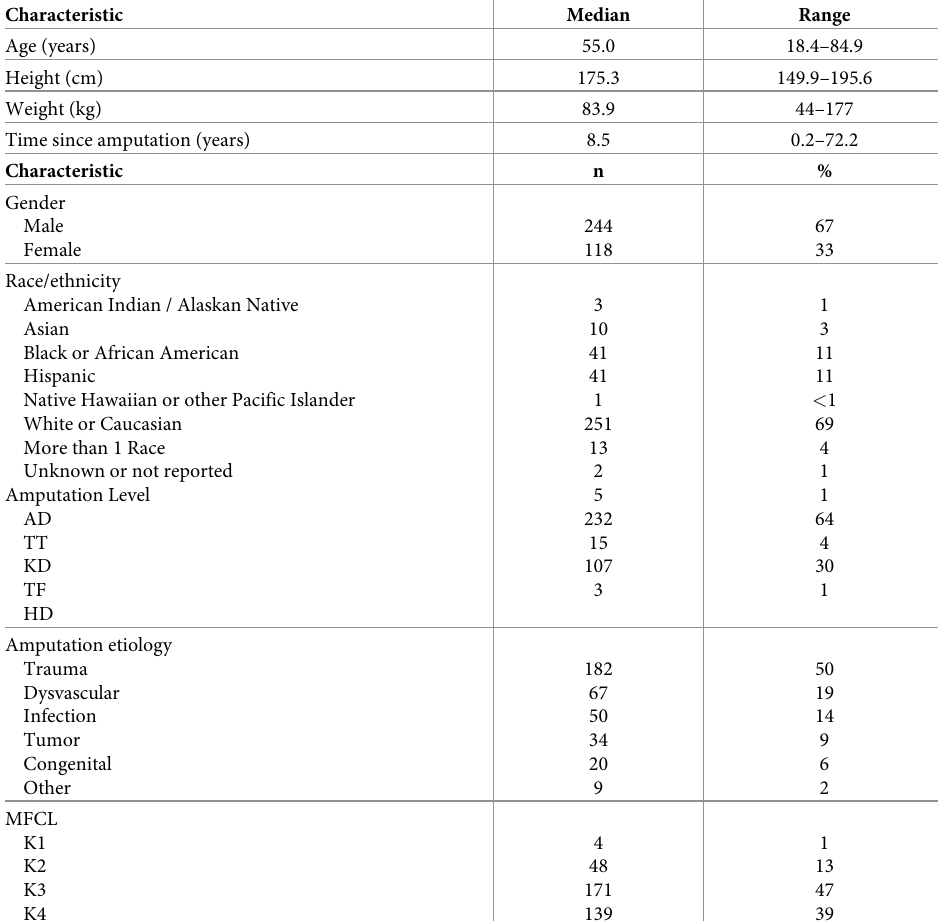
Table 1. Characteristics of the study sample (N =